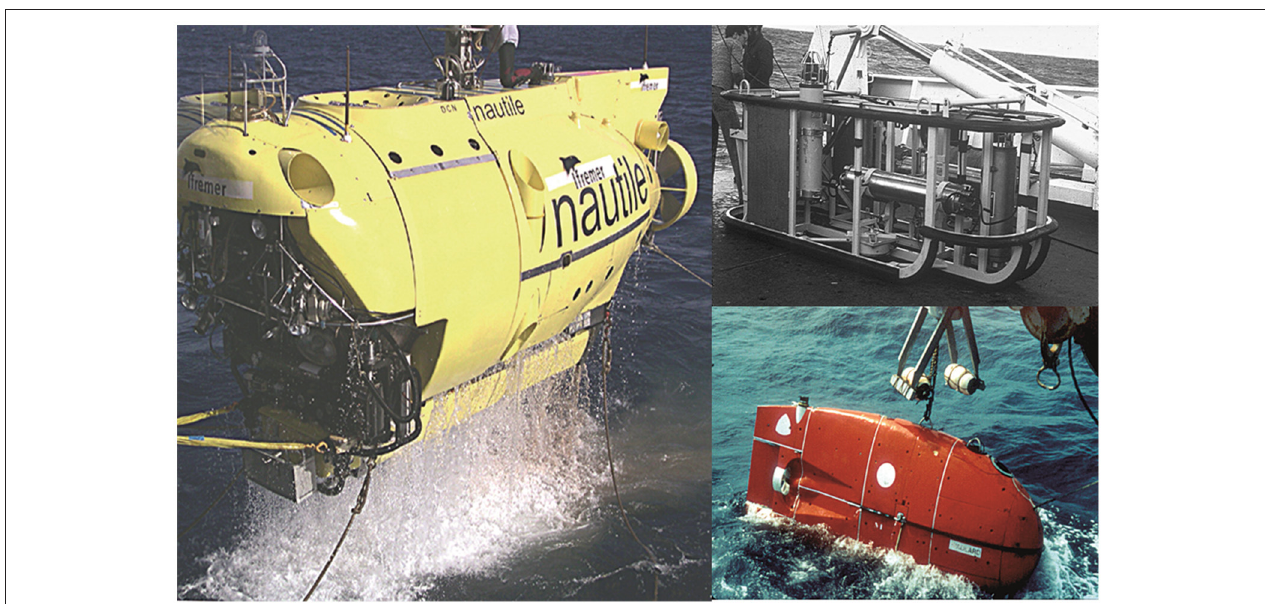
FIGURE 3 | Principle platforms deployed during exploration and sampling of the French NORIA area. (Left) Manned submersible “Nautile” (Top right) Towed “R.A.I.E”; (Bottom right) Remote controlled submersible “Epaulard” ( © all figures IFREMER) http://unesdoc.unesco.org/images/0014/001495/149556f.pdf, volume 1, Figures 20, 28, 30 ( Tilot, 2006a), http://unesdoc.unesco.org/images/0014/001495/149556e.pdf#223, volume 3, Appendix I, Figures 10, 11 (Tilot, 2010b).